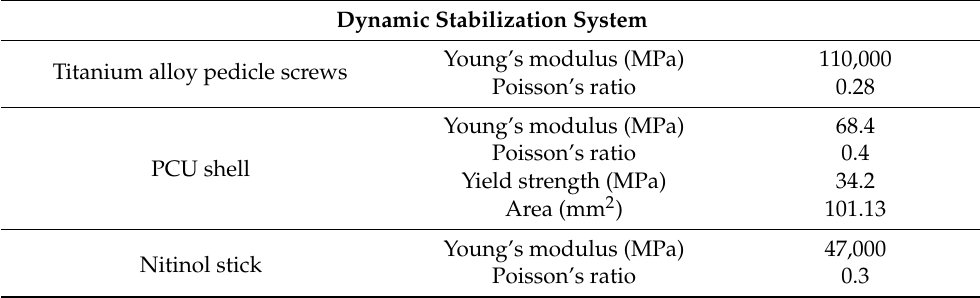
Table 2. Material properties of implants used in FEM.